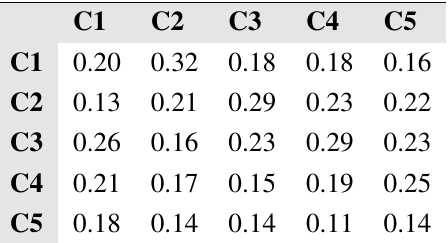
Table 3. Normalized comparison rating matrix (n = 34).